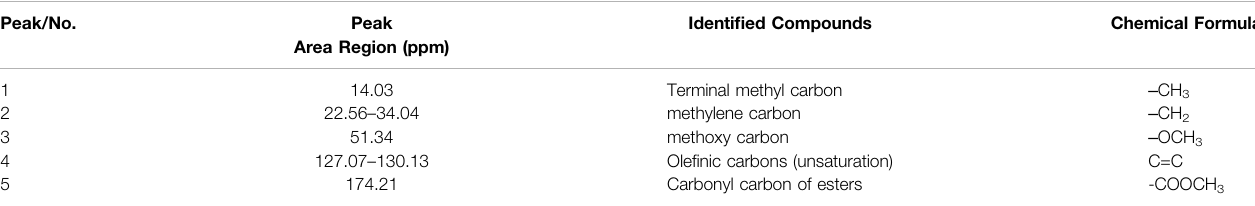
TABLE 6 | C13 NMR spectrum of Cucumis melo var. agrestis biodiesel. Peak/No.